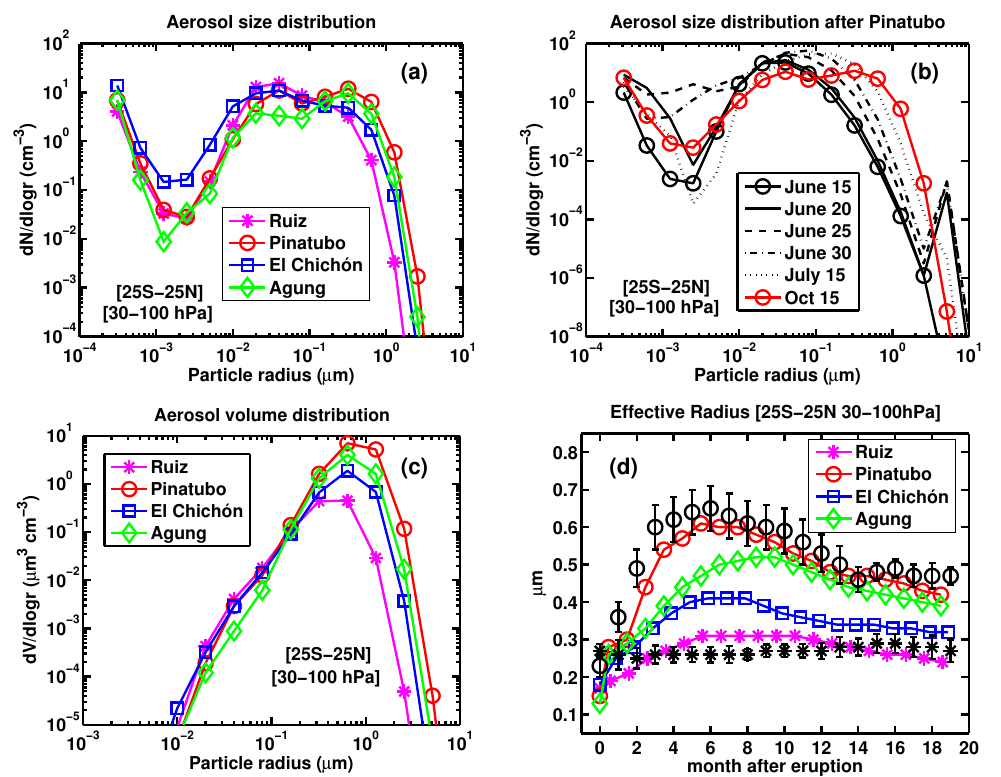
Figure 11. Panel ( a ) ULAQ-CCM-calculated aerosol size distribution [dN/dlogr] (cm ´ 3 ) averaged between 25 ˝ S ´ 25 ˝ N latitude and 30 ´ 100 hPa, four months after each eruption (see legend for the line styles adopted for the tropical eruptions considered in this study). Panel ( b ) as in ( a ), but for the Pinatubo case as a function of time, from immediately before the eruption (June 15, 1991) to June 30 every 5 days and then 15 July and 15 October, i.e. , four months after the eruption, as in panel ( a ). Panel ( c ) as in ( a ), but the volume distribution [dV/dlogr] ( µ m 3 ¨ cm ´ 3 ) is a proxy of the mass distribution. Panel ( d ) time series of the aerosol effective radius ( µ m), calculated in the lower stratospheric tropical domain (25 ˝ S ´ 25 ˝ N and 30–100 hPa); black symbols show SAGE-II-retrieved values [64], with open circles for Pinatubo (1991/92) and asterisks for Ruiz (1986/87). SAGE-II effective radius values for the first 12 months after the Pinatubo eruption are calculated by interpolating the missing data in the 20–25 km layer (due to instrument